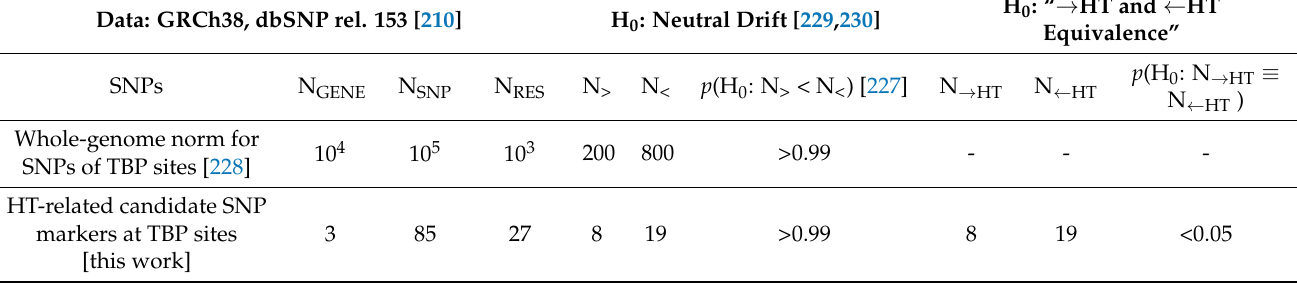
Table 11. The hypertension-related candidate SNP markers within HBB , HBD, and PCDHB9 promot- ers (predicted here) and their comparison with genome-wide